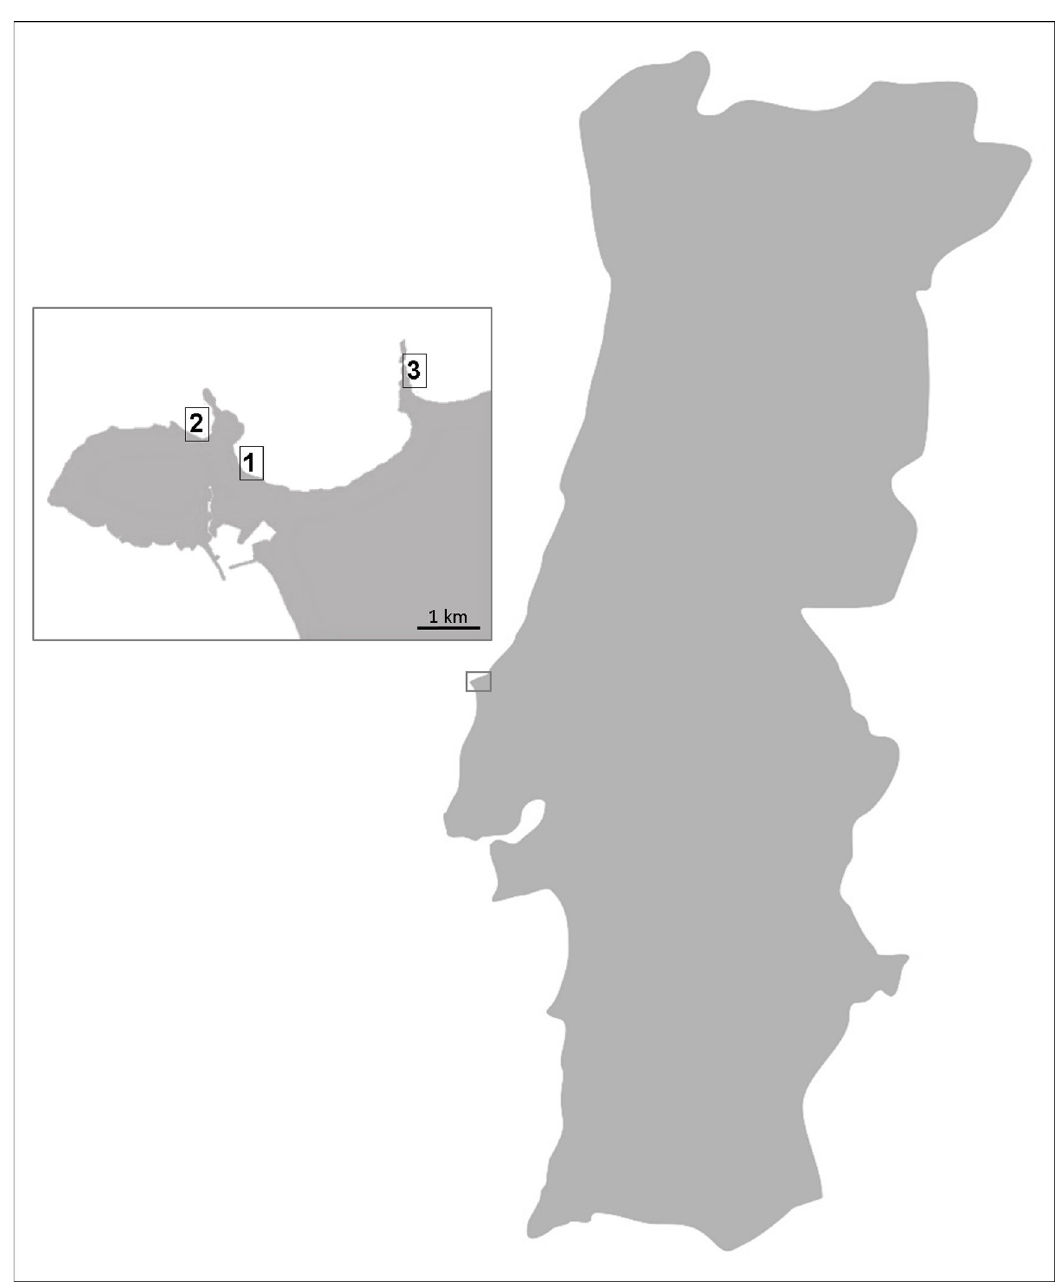
Fig 1. Collection areas: Gamboˆa (39.3651˚N, 9.3728˚W; 1); Portinho da Areia Norte (39.3691˚N, 9.3779˚W; 2); Baleal, praia dos Barcos (39.3766˚N, 9.3402˚W; 3).